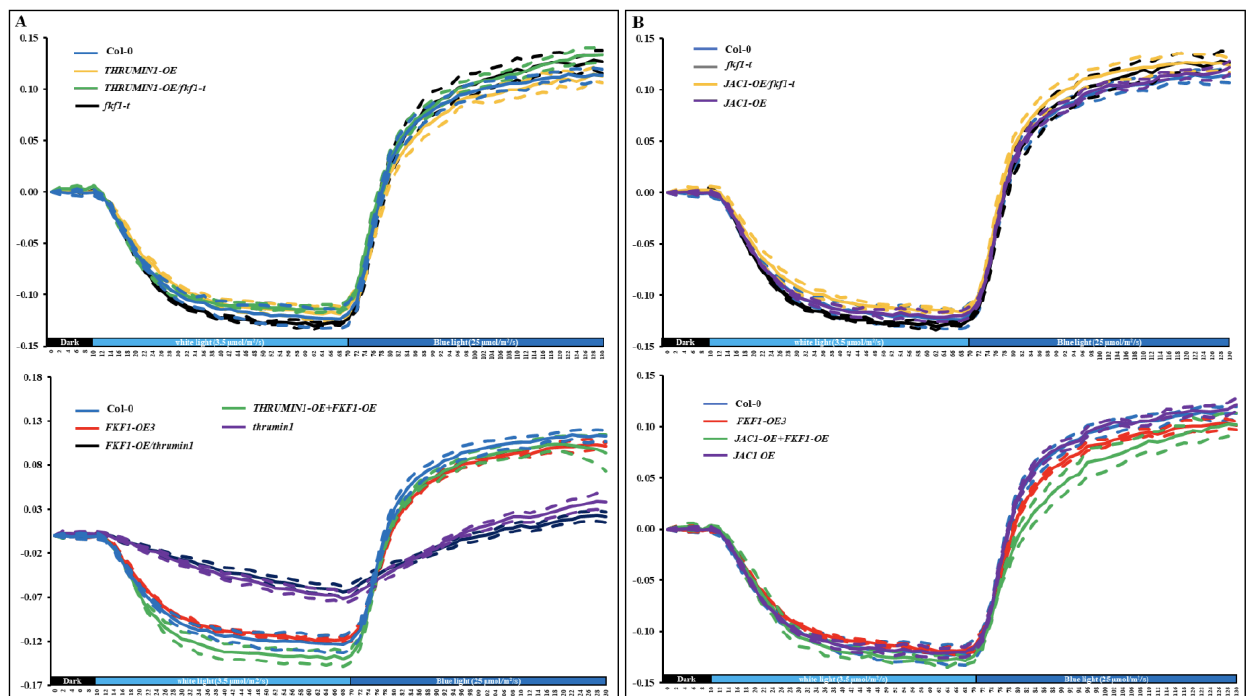
Figure 8. Chloroplast relocation studies using red light transmittance assay in various Arabidopsis lines. ( A ) Chloroplast movement in Col-0, fkf1-t , and FKF1-OE3, THRUMIN1-OE, thrumin1 , THRUMIN1-OE/ fkf1-t , FKF1-OE/ thrumin1 , and Thrumin1-OE + FKF1-OE in response to sequential treatments of white light and monochromatic blue light. Red-light transmittance was measured for 10 min in dark adapted leaves to establish a baseline, followed by a sequential 60 min treatment of 3.5 µmol/m 2 /s white light, and then a 50 min treatment of 25 µmol/m 2 /s monochromatic blue light. Red-light transmittance was recorded every 2 min. ( B ) Chloroplast movement in Col-0, fkf1-t , FKF1-OE3, JAC1-OE/ fkf1-t , JAC1-OE, JAC1-OE + FKF1-OE in response to sequential treatments of white light and monochromatic blue light. Red-light transmittance was measured for 10 min in dark adapted leaves to establish a baseline, followed by a sequential 60 min treatment of 3.5 µmol/m 2 /s white light, and then a 50 min treatment of 25 µmol/m 2 /s monochromatic blue light. Red-light transmittance was recorded every 2 min. The data are an average of red-light transmittance changes from at least 3 independent leaves collected from 3 different plants. Dashed lines represent S.D. (3 ≤ n ≤ 8). A Student’s t test was used to test the difference between the means from two groups. Y-axes: Δ red-light transmittance; X-axes: time in min.